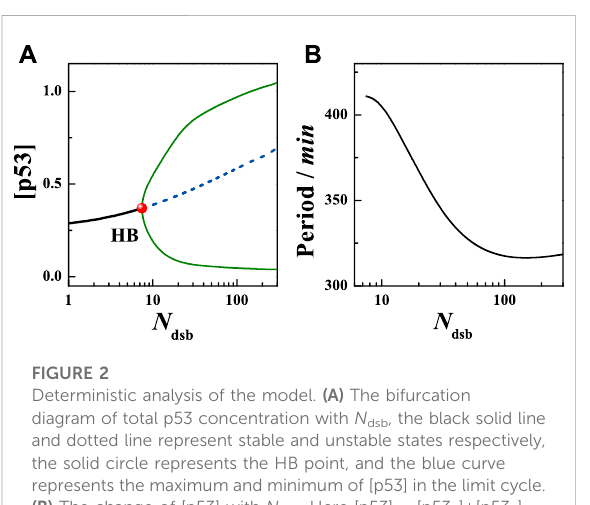
FIGURE 4 Timeevolutionsof[p53 p ],withdifferent k deatmwip .Fromtopto down, k deatmwip = 0.05, 0.3, 0.62 respectively. The parameter N dsb =